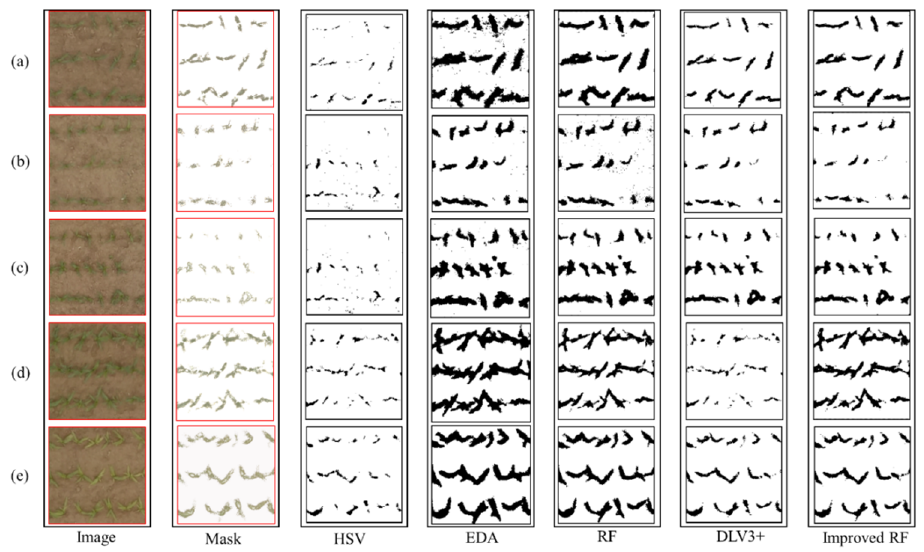
Figure 3. Estimate of the maize leaf coverage generated by di ff erent methods. Panels ( a – e ) show leaf-coverage images selected at random from the dataset.